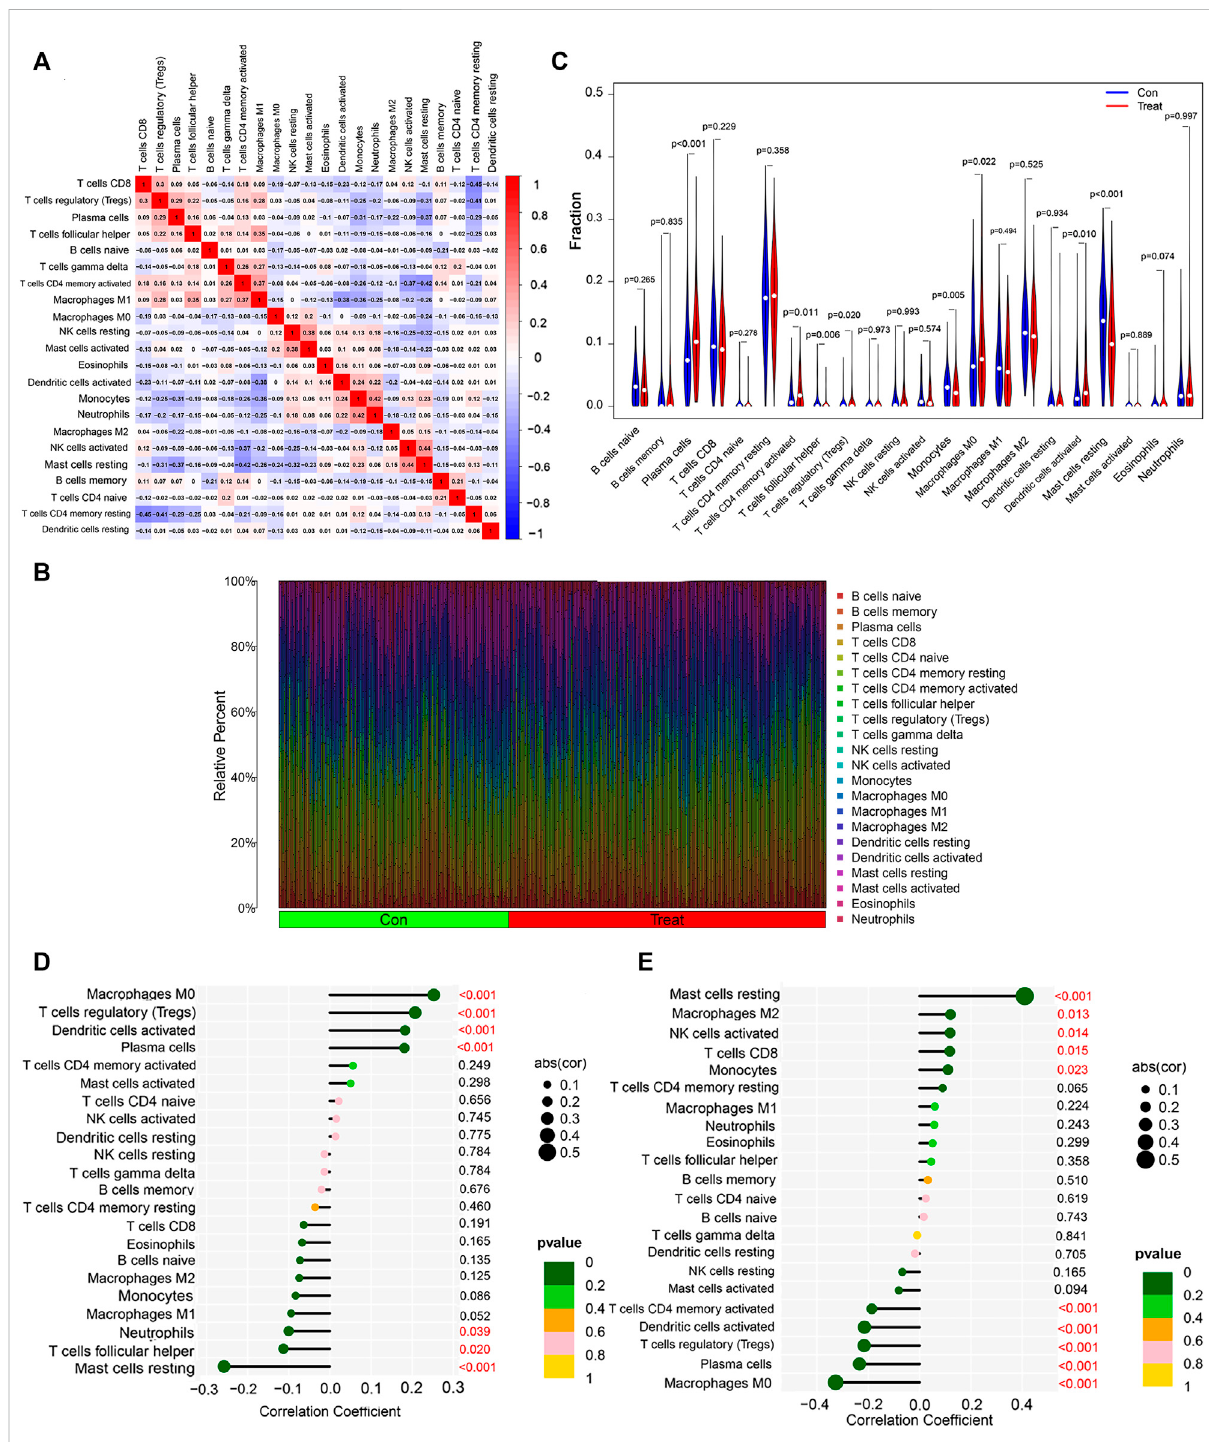
FIGURE 6 Immune in fi ltration analysis of non-small cell lung cancer. (A) Correlation analysis among 22 immune cell types. (B) Visualization of the degree of in fi ltration of multiple immune cells in non-small cell lung cancer samples. (C) Changes in the distribution of 22 immune cell types in non-small cell lung cancer tissues and their controls. (D) Relationship between RHEBL1 and the level of immune cell in fi ltration, where red color is statistically signi fi cant, p < 0.05. (E) RelationshipbetweenRNPC3andthelevelofimmunecellin fi ltration,whereredcolorisstatisticallysigni fi cant, p <